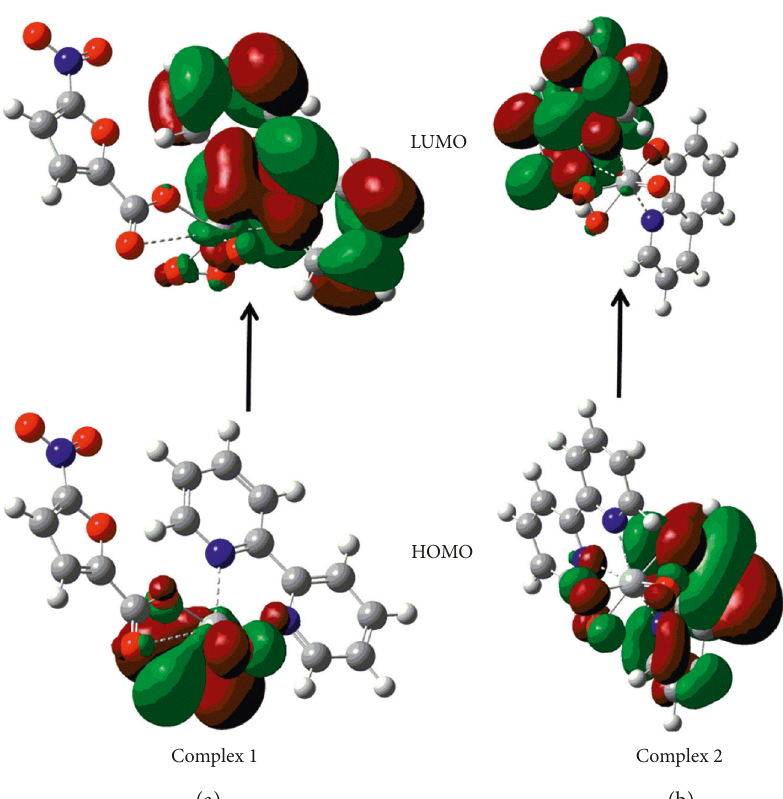
Figure 18: Frontier molecular orbitals density plots of complexes 1 (a) and 2 (b) obtained at wb97xd/6–311++g (2d, 2p) level of